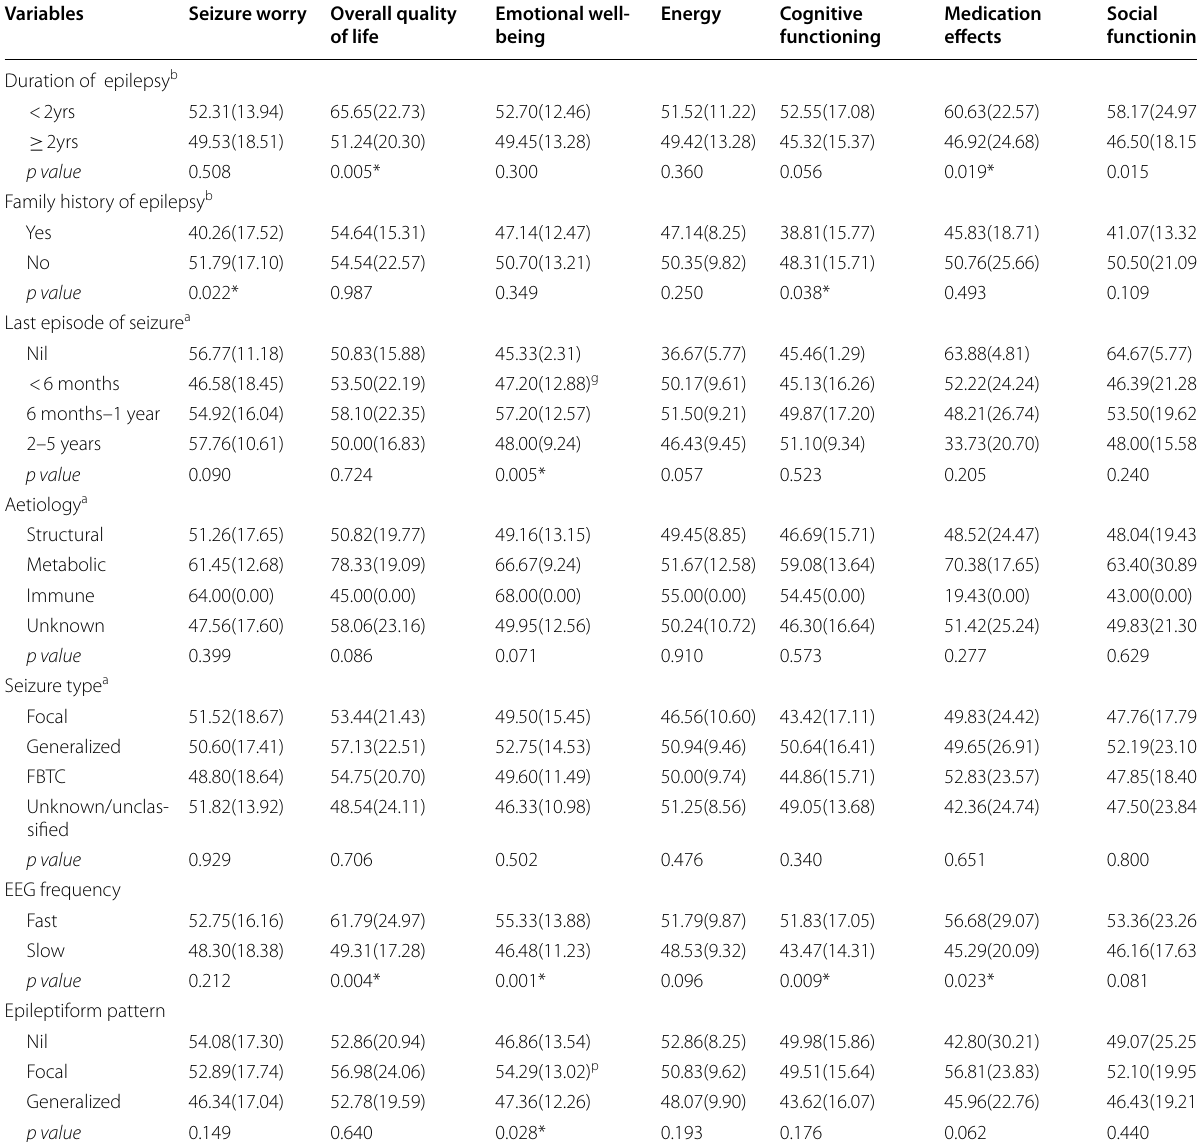
Table 4 Relationship between seizure characteristics and QOLIE‑31